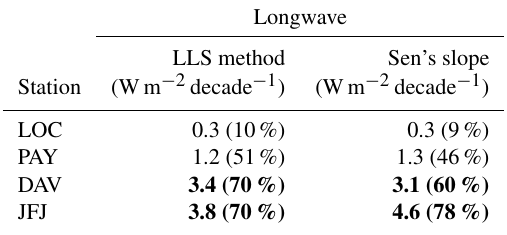
Table 6. Trend analysis of the longwave discrepancies during cloud- free conditions for the 1996–2015 period at all four stations. Trend values in italic (bold) are significant at the 90% (95%) level. Per- centage values in brackets correspond to the contribution of the dis- crepancy to the overall trends in Table